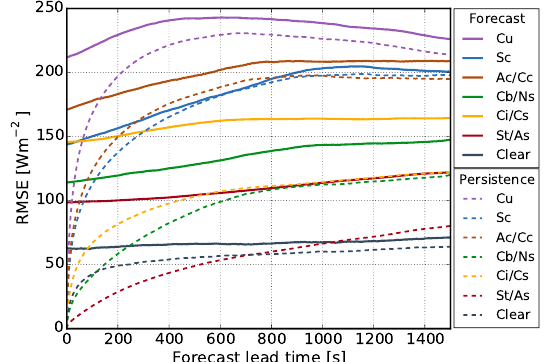
Figure 11. Average forecast skill of all stations depending on fore- cast horizon. The classified cloud types are summarized in two groups. The coloured confidence interval illustrates the standard de- viation of the forecast skill of all stations.